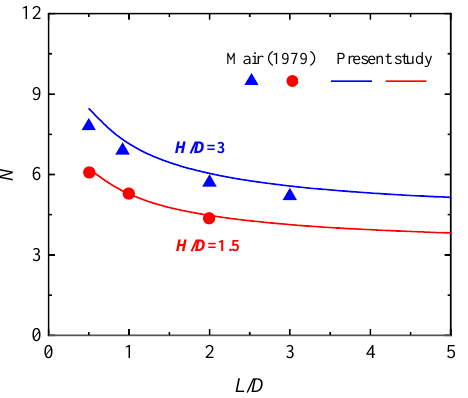
Figure 4. Comparison of predicted stability numbers with 2D centrifuge model tests.